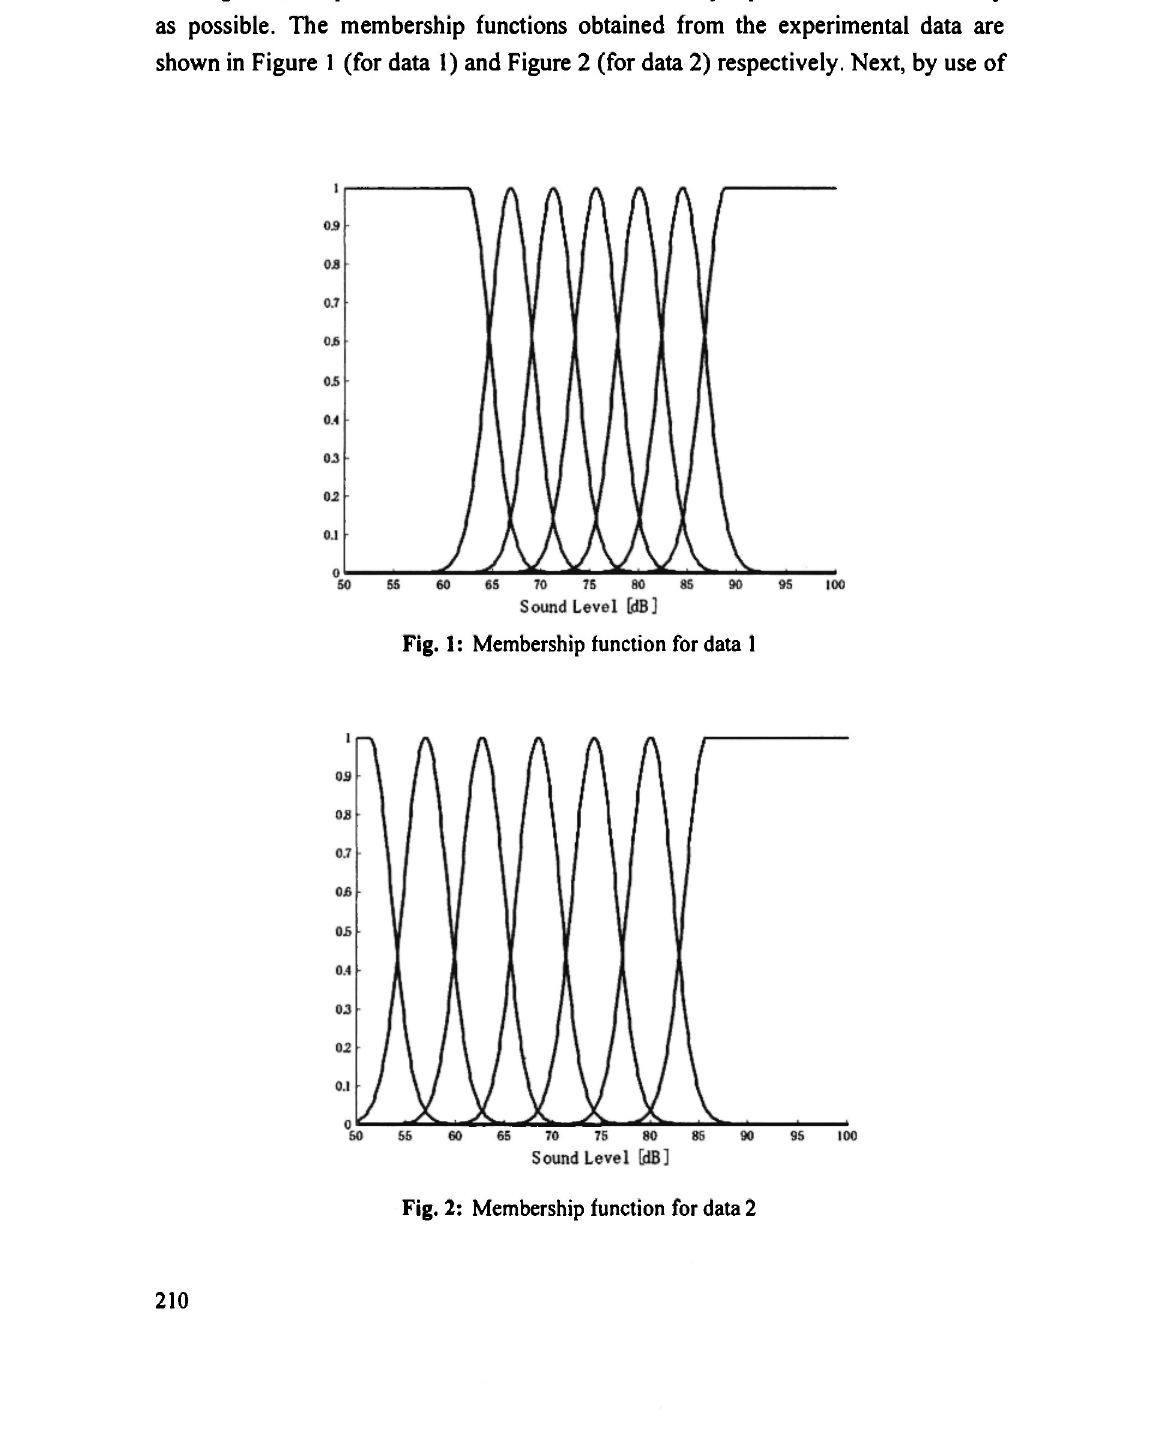
Fig. 2: Membership function for data